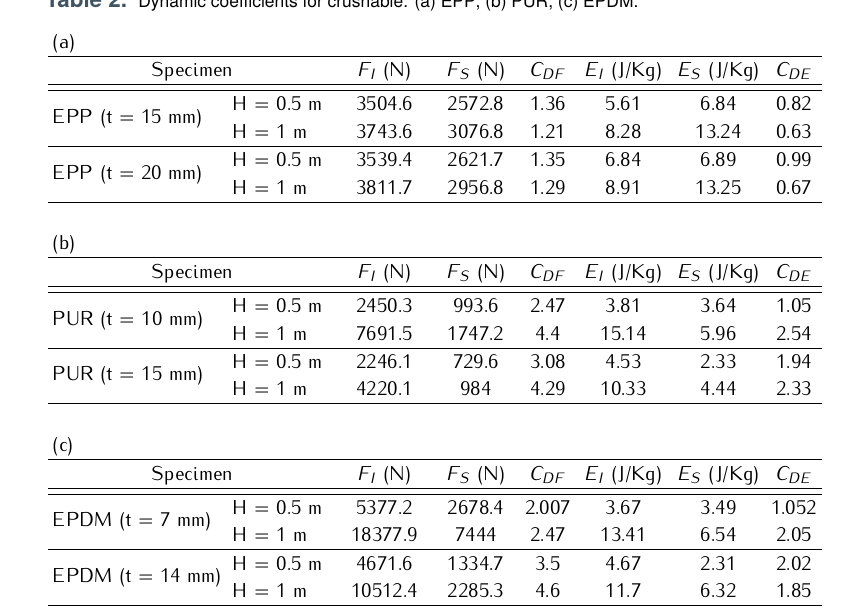
Table 2. Dynamic coefficients for crushable: (a) EPP; (b) PUR; (c)